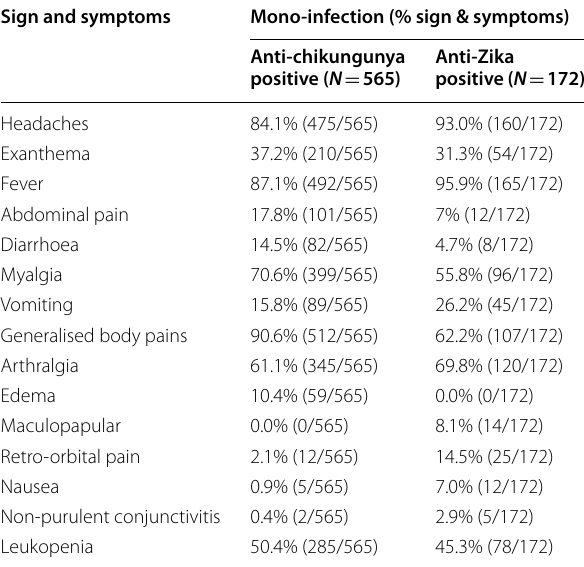
Table 2 Signs and symptoms presented by chikungunya or Zika monoinfected